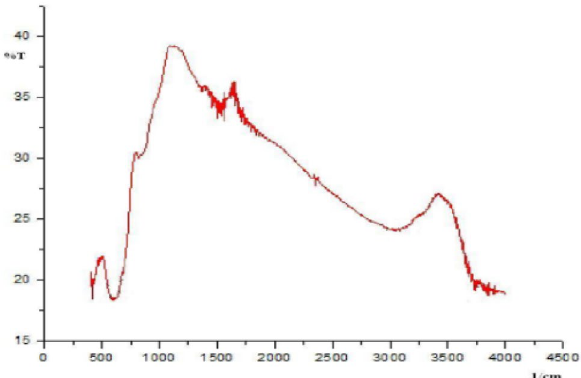
Figure 5. Infrared spectrum of magnetite Fe 3 O 4 without peaks corresponding to organic functional groups.